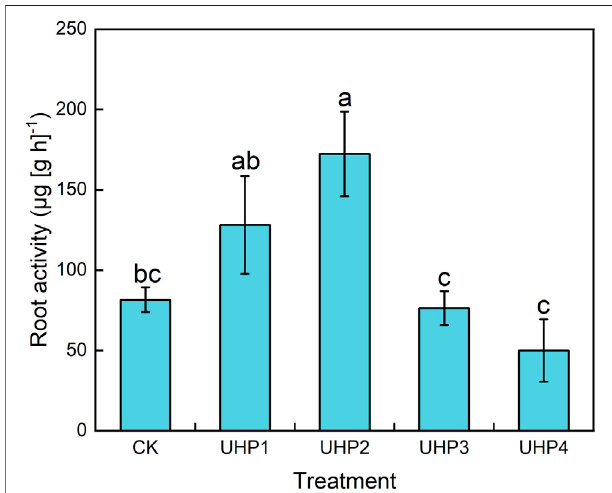
FIGURE3| Effectsofaerationontherootactivityofamaranthatharvest. Bars indicate the mean ± SD. Different letters on the bars indicate signi fi cant differences ( p < 0.05).